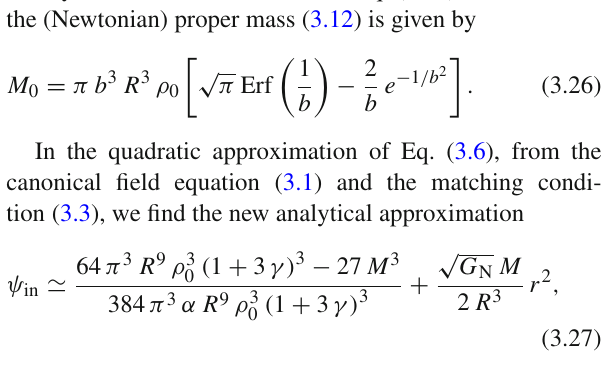
Fig. 2 Upper panels: inner potentials ˜ V in (dotted line), V in (dashed line), ˆ V in (solid line) and outer potential ˜ V out (solid line) for X = 1 / 100 (left panel), X = 1 / 20 (center panel) and X = 1 / 5 (right panel). Lower